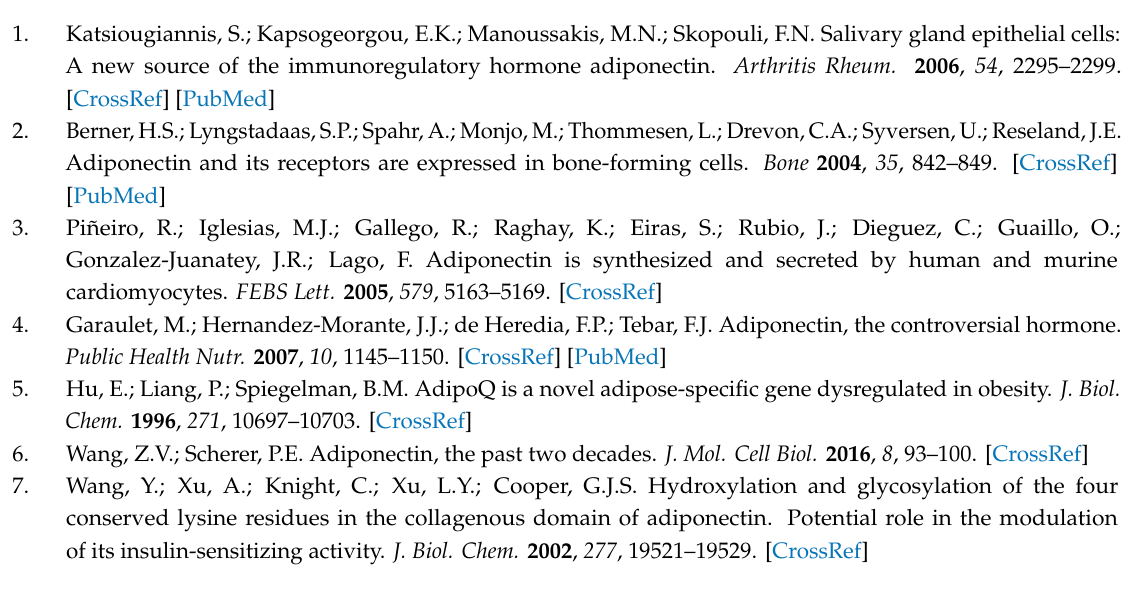
Table S1: Search strategies for PubMed, Web of Science, Scopus, ProQuest and Biological Abstracts via Ovid, Table S2: Excluded articles from database searching, Table S3: Coding data of studiess from search